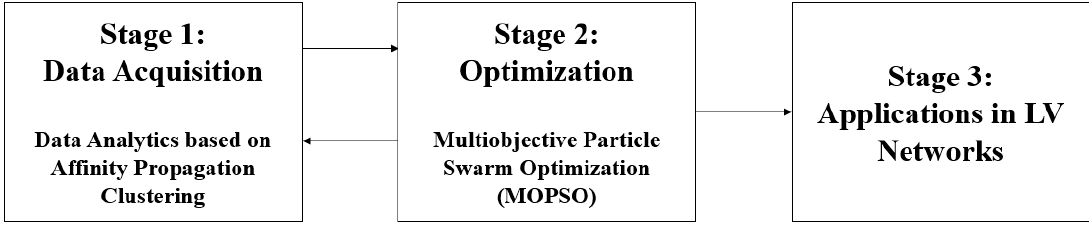
Figure 4. Stages of the methodology proposed.